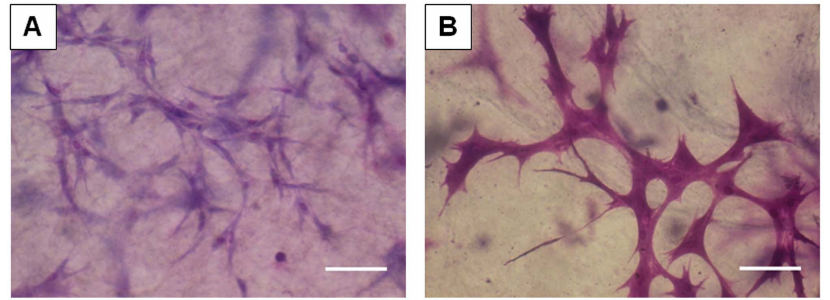
Figure 1. Effects of NPWT on morphological change. Control cells were thin with elongated spindle shape (A). The cells that were applied with NPWT were larger and thicker with many dendrite-like branches (B). Scale bar represents 100 m m.